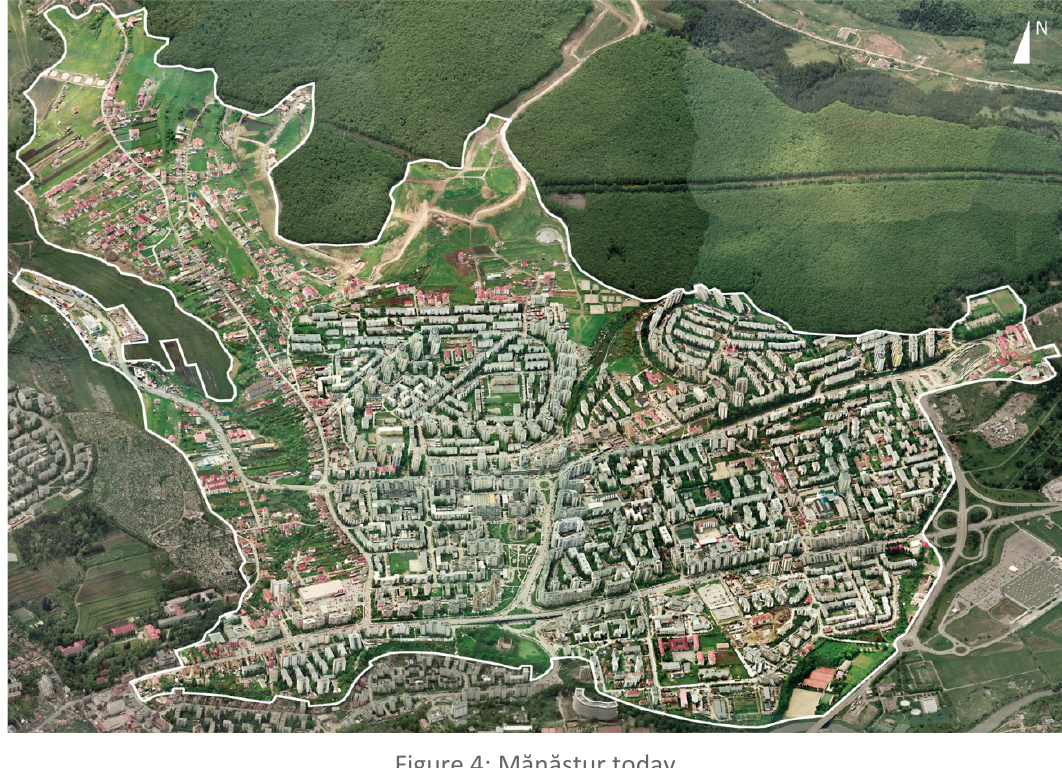
Figure 4 : Mănăştur